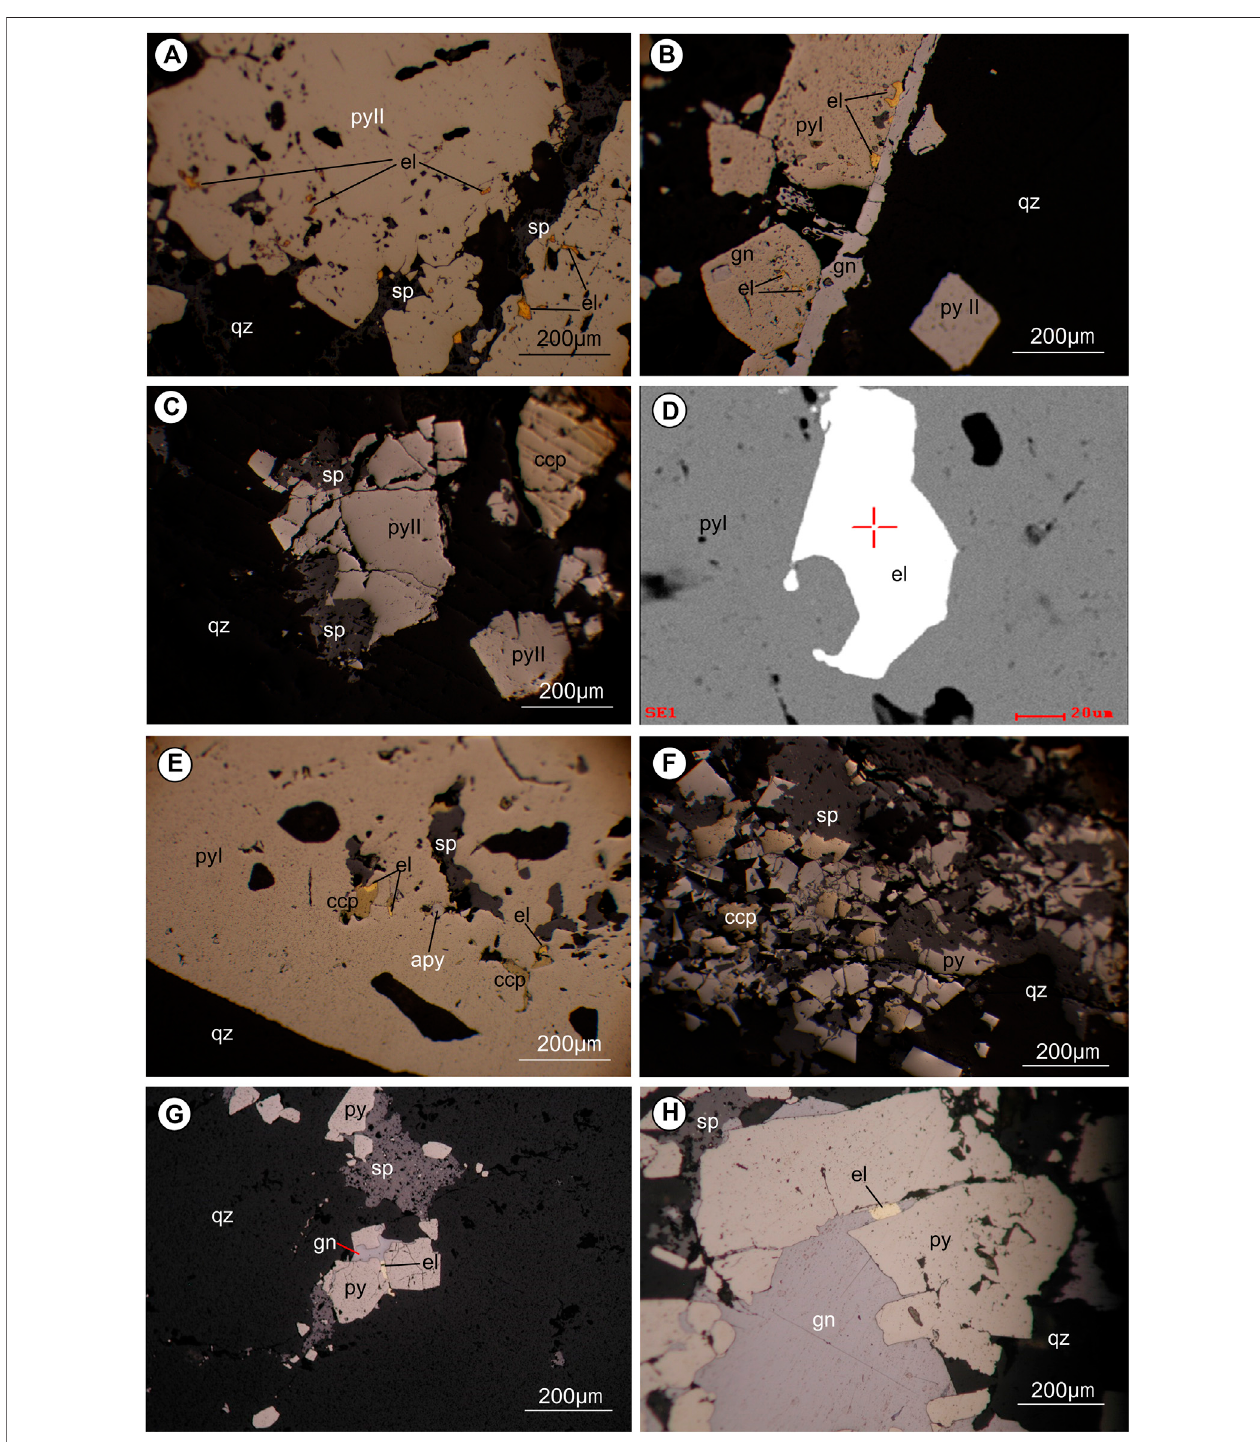
FIGURE9| Photomicrographsshowing (A) electruminclusioninsubhedralpyrite(pyII)withsphaleriteofthegold-bearingquartzveininadit-IfromShwetagun, (B) fractured electrum fi lled with euhedral pyrite (py I) and galena, suggesting their chronological relationship of the gold-bearing quartz vein in adit I from Shwetagun, (C) euhedral pyrite (py I) associated with sphalerite and chalcopyrite of the gold-bearing quartz vein in adit-III from Shwetagun, (D) backscattered electron image with an electrum grain in pyrite from Shwetagun, (E) electrum inclusion is surrounded by chalcopyrite, sphalerite and arsenopyrite in pyrite from Shwetagun, (F) massive pyrite aggregates with chalcopyrite, and sphalerite of quartz-carbonate-sul fi de vein from the Kunzeik, (G) and (H) fractured electrum fi lled with euhedral pyrite, galena and sphalerite of quartz-sul fi de vein from Zibyaung. Figures (g) and (h) are taken from Myo Kyaw Hlaing et al. (2019). Abbreviations: py (cid:1) pyrite, gn (cid:1) galena, ccp (cid:1) chalcopyrite, sp (cid:1) sphalerite, apy (cid:1) arsenopyrite, el (cid:1) electrum and qz (cid:1) quartz.